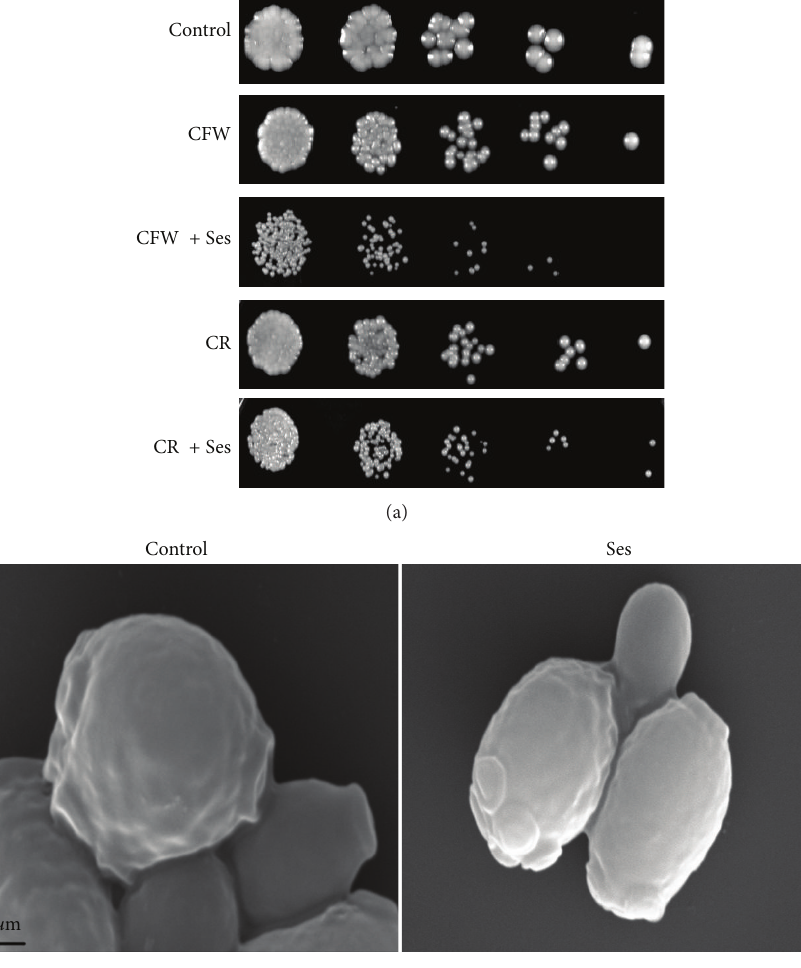
Figure 7: Effect of Ses on the cell wall integrity of C. albicans . (a) Spot assay showing no effect to Ses (0.552 mg/mL) in the presence of cell wall perturbing agents; CFW (10 𝜇 g/mL) and CR (10 𝜇 g/mL). (b) Scanning electron micrographs, as described in Section 2, showing the smooth surface of untreated cells (control) and treated